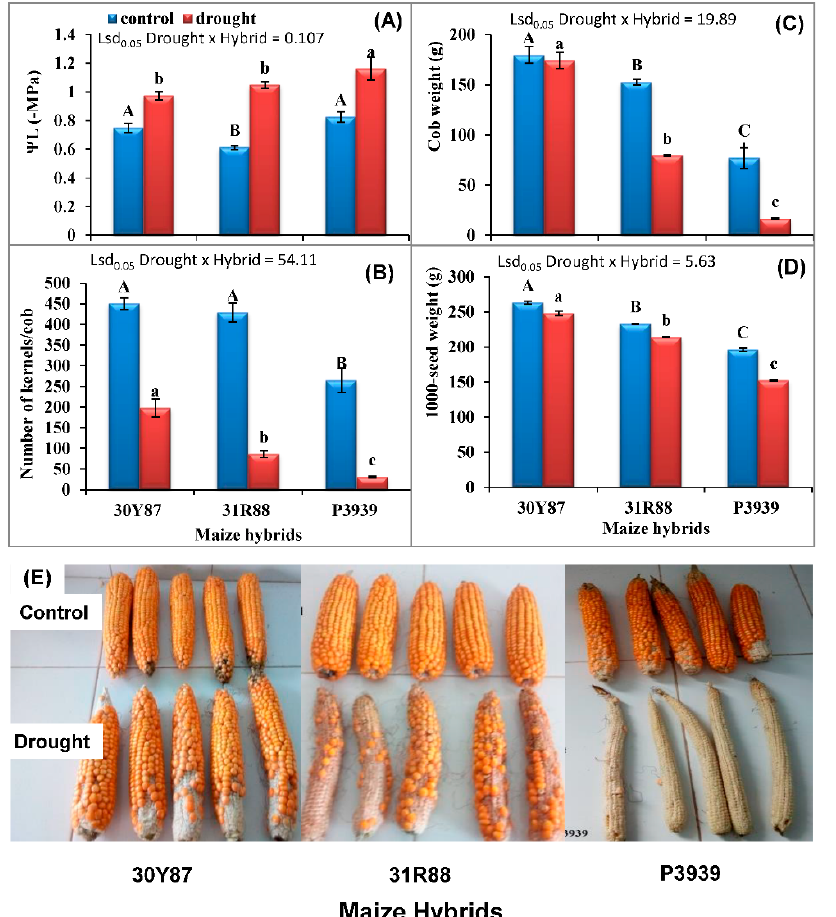
Figure 5. Leaf water potential ( Ψ L ) ( A ), number of kernels/cob ( B ), cob weight ( C ), and 1000-seed weight ( D ) of three maize hybrids when two-week-old plants were subjected to three cycles of drought stress. Blue bars are control, red bars with markers are water stress. Bars represent the calculated standard error (n = 4 for leaf water potential and n = 12 for yield attributes from field experiment). ( E ) Cobs of three maize hybrids grown under normal or drought conditions reflecting maize hybrids yield.